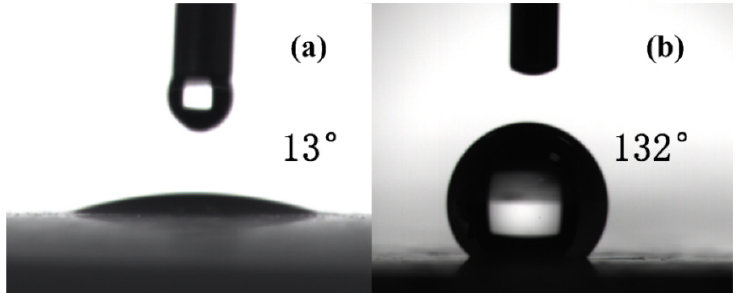
Figure 3. The contact angle of original ( a ) and hydrophobized ( b ) magnetite.